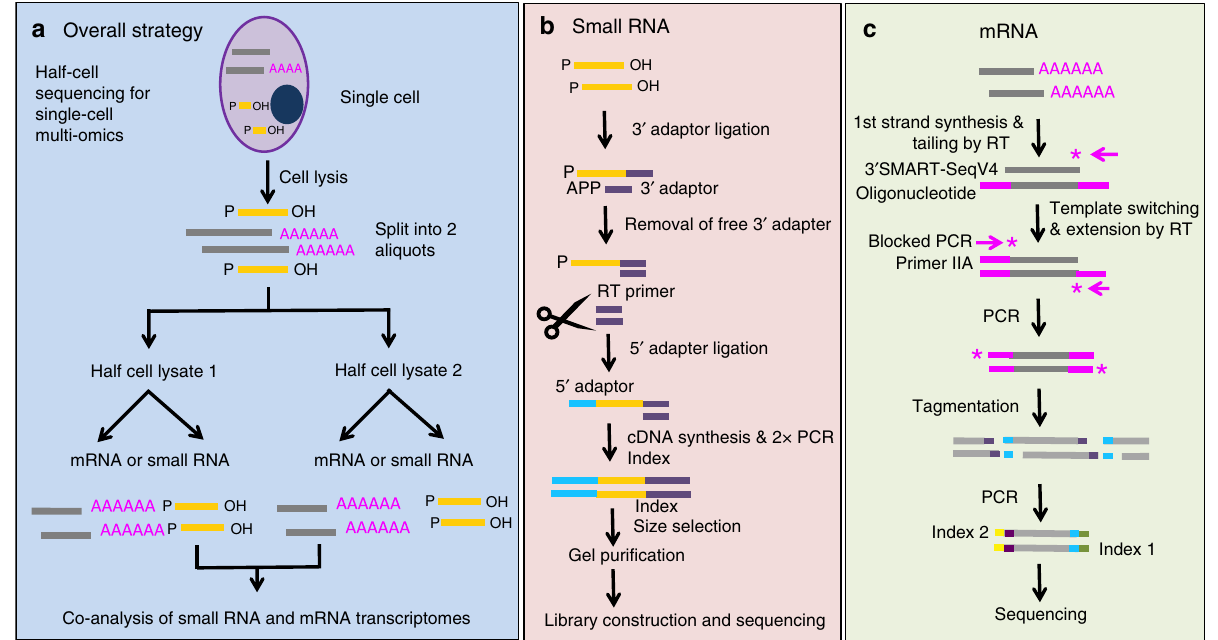
Fig. 1 Experimental work fl ow. a Overall strategy for pro fi ling miRNA and mRNA from the same single cells using half-cell genomics. It involves cell lysis, half-cell split, followed by small RNA & large RNA library preparation. b For miRNA library preparation, a pre-adenylated (APP) 3 ′ adaptor was used to ligate to the 3 ′ end of miRNA molecules, followed by digestion of unreacted 3 ′ adaptor, ligation with 5 ′ adaptor, RT and PCR ampli fi cation. c For mRNA library preparation, fi rst-strand cDNA synthesis was primed by the 3 ′ SMART-Seq CDS Primer IIA. Template switching at the 5 ′ end of transcript was performed using the SMART-Seq v4 oligonucleotides. After PCR ampli fi cation, cDNA was fragmented using Illumina ’ s Tagmentation